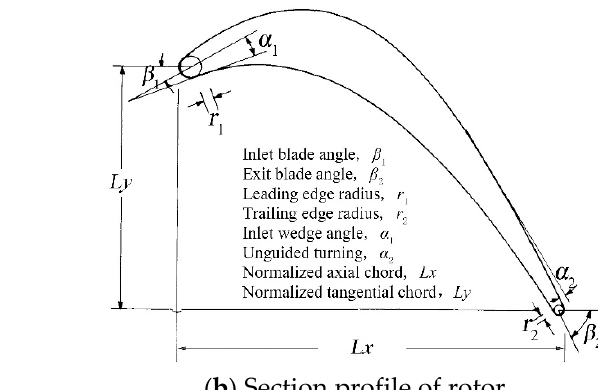
Figure 10. Schematic of conformal mapping. Stator Blade